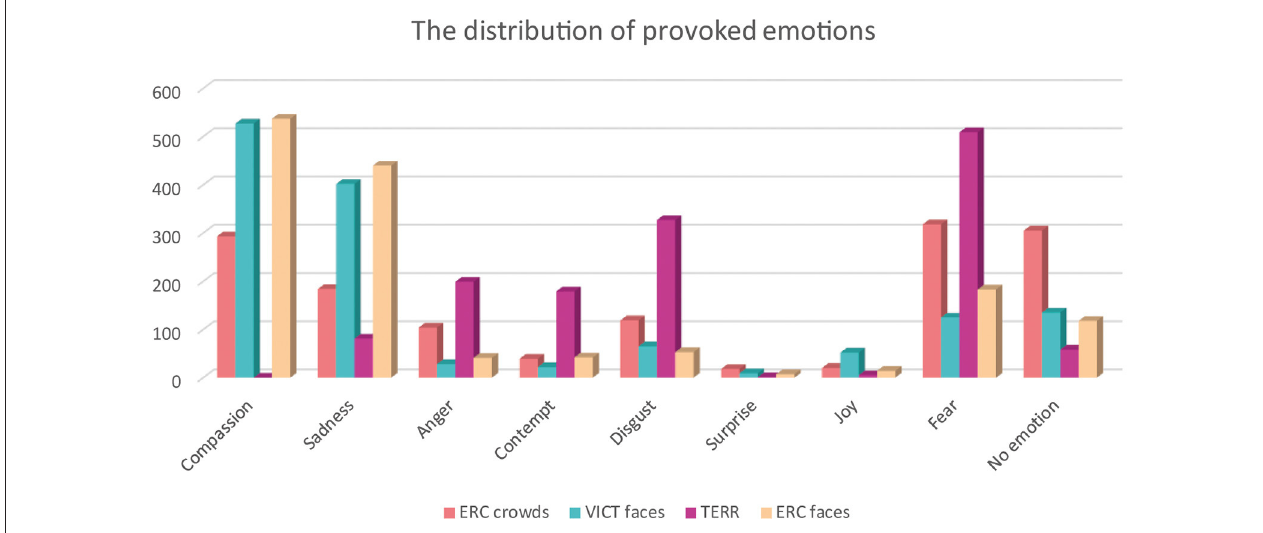
FIGURE 4 | The distribution of emotions provoked by the four categories of photographs. Individual categories of photographs are presented in various colors. The figure shows cumulative number of responses of the specific emotion in each category of photographs ( N = 1,400 responses in total for each category).